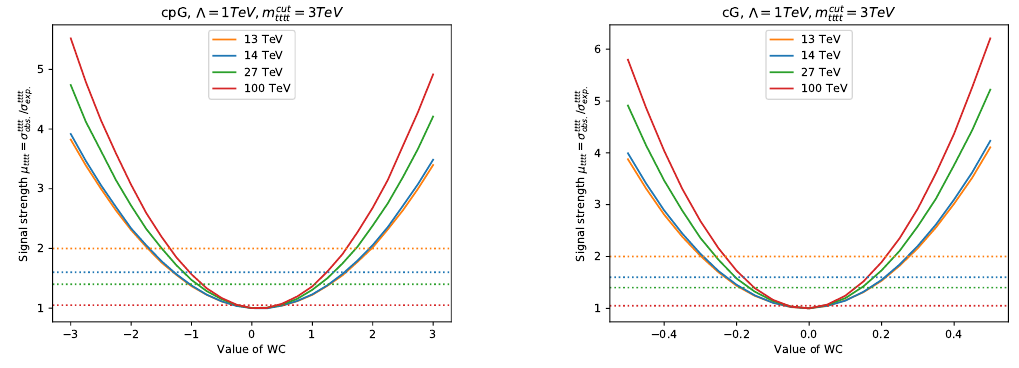
Figure 17 . Same as figure 15 but for the O